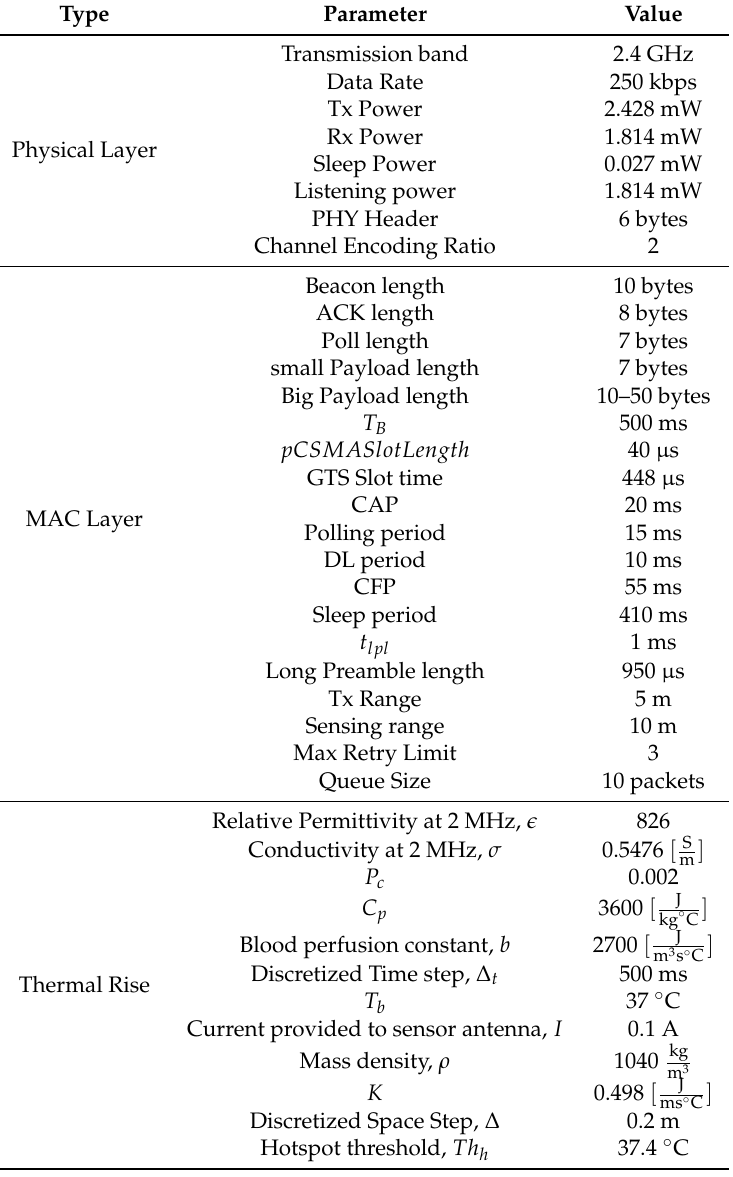
Table 3. Parameters and their values used in the